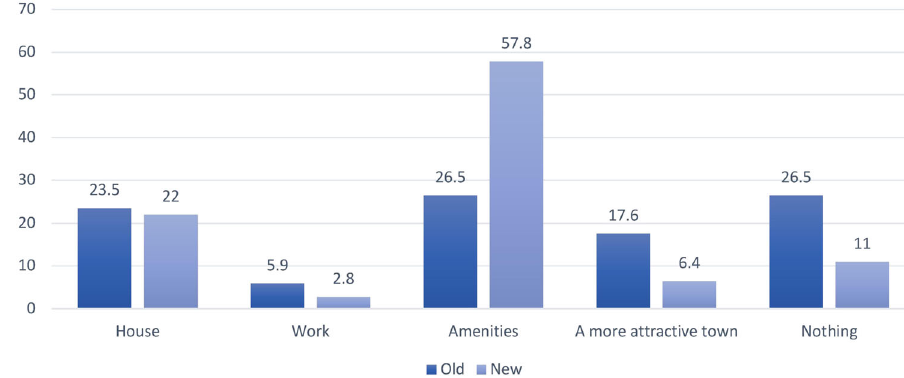
Fig. 3 Local community. The most important gains after the forced removal.